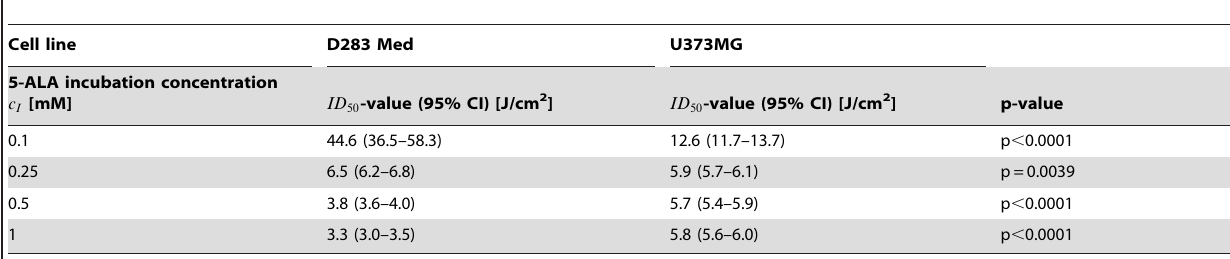
Table 3. Comparison of 5-ALA phototoxicity of medulloblastoma vs. glioma.